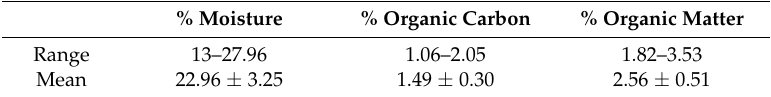
Table 7. Percentage moisture, organic carbon and organic matter contents of the sediments.